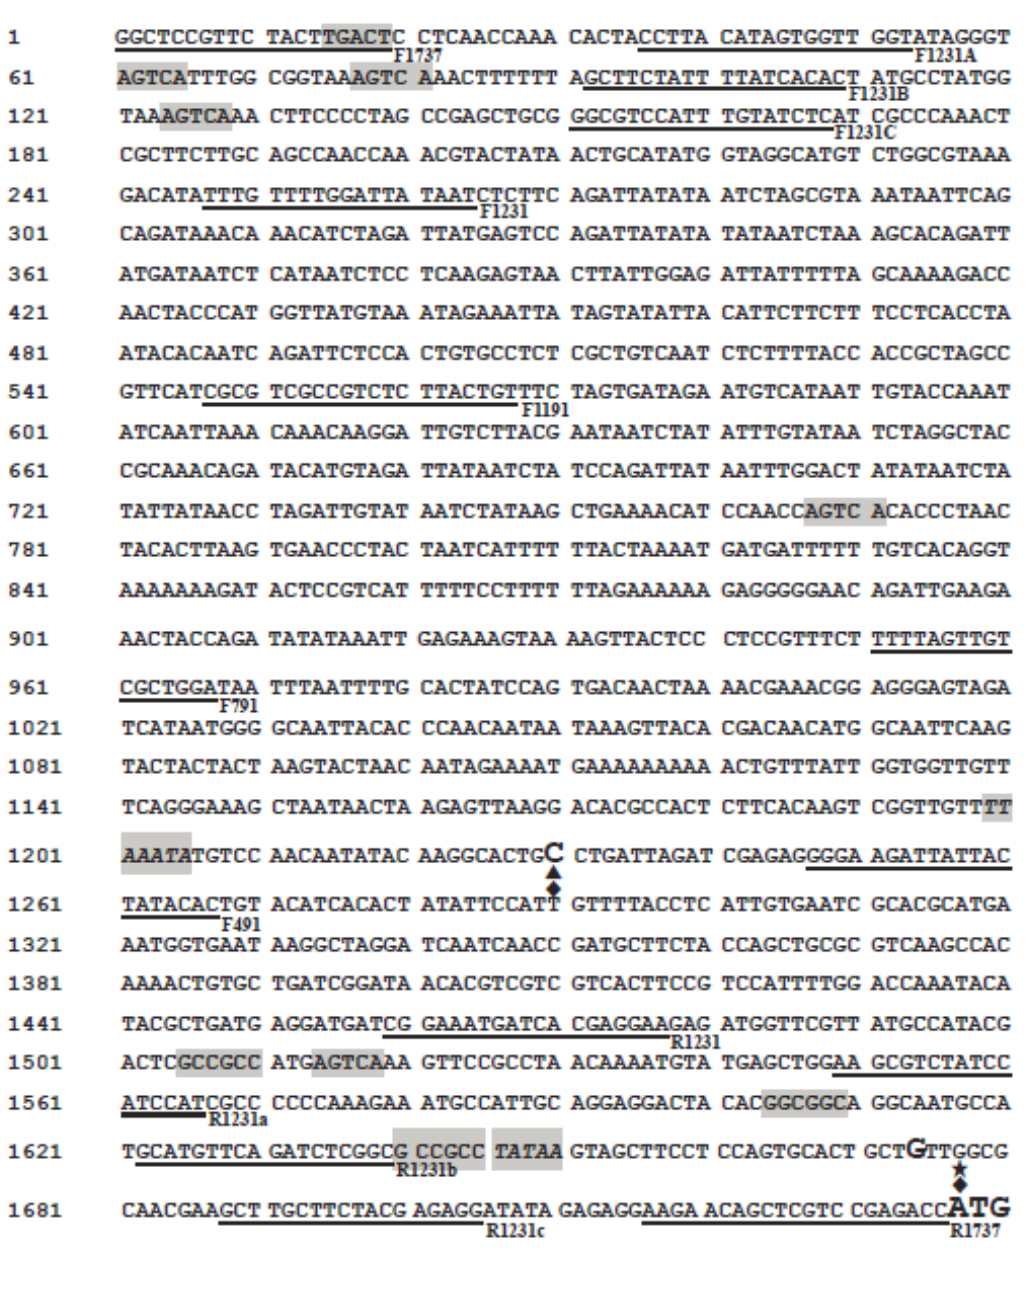
Figure 1. The maize Wip1 promoter sequence. The start codon (ATG) and putative transcription start sites are indicated in larger letters. The putative TATA boxes are shadowed and italicized. The W-box and GC-box are shadowed only. The primers used for PCR amplification are underlined and given corresponding names. Triangle ( ▲ ) indicates the transcription start site of GUS in Wip ::GUS line; rhombuses ( ♦ ) indicate the 1231 ::GUS line; asterisk ★ ( ) means the transcription transcription start site of GUS in Wip 1737 start site of Wip1 in